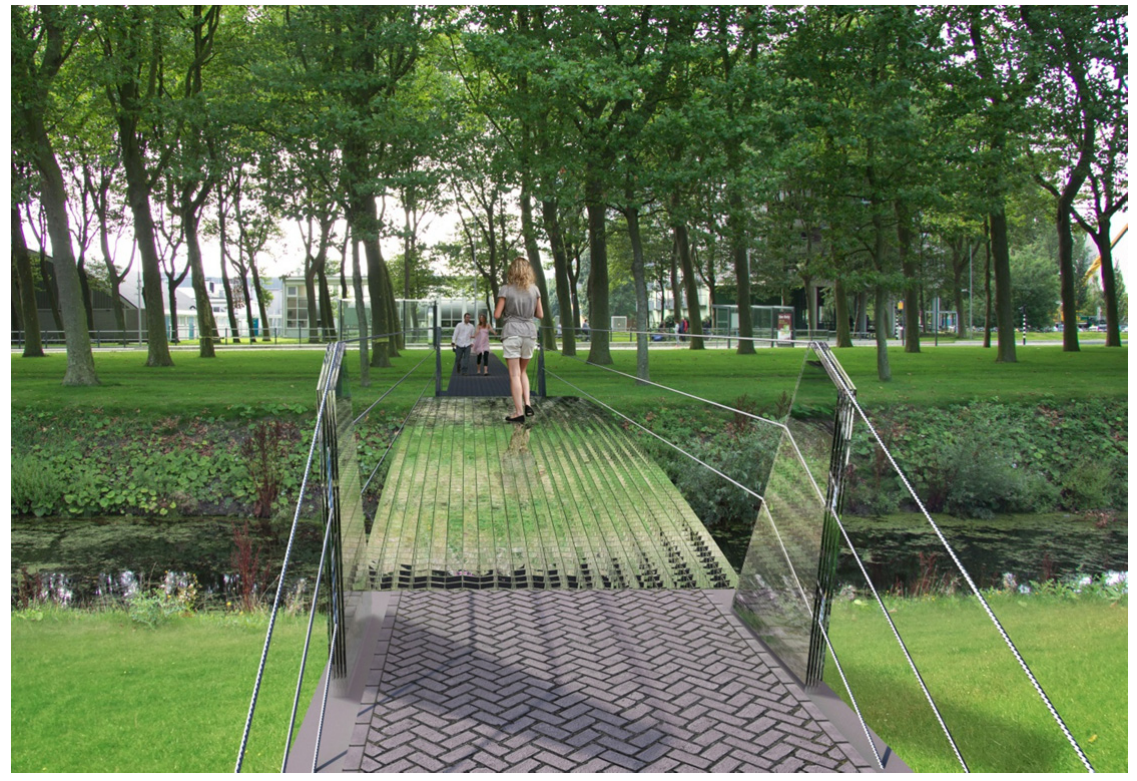
Fig. 28 Artist impression of the